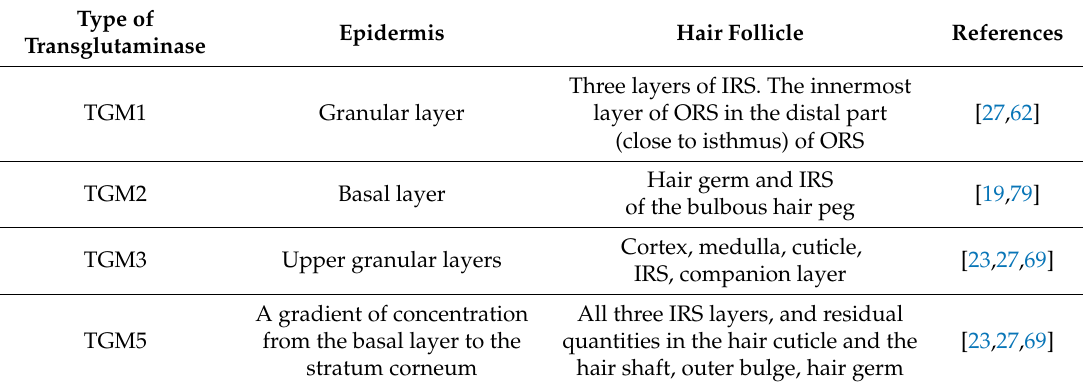
Table 2. Distribution of TGMs in the epidermis and the hair